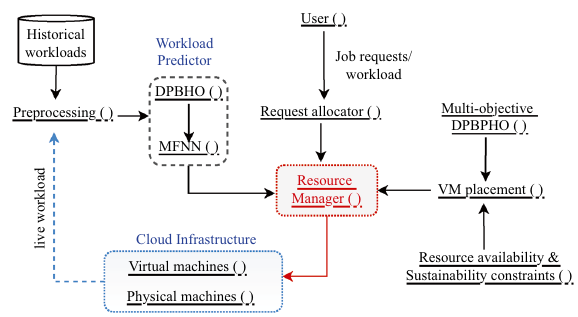
Figure 10. Design and operational